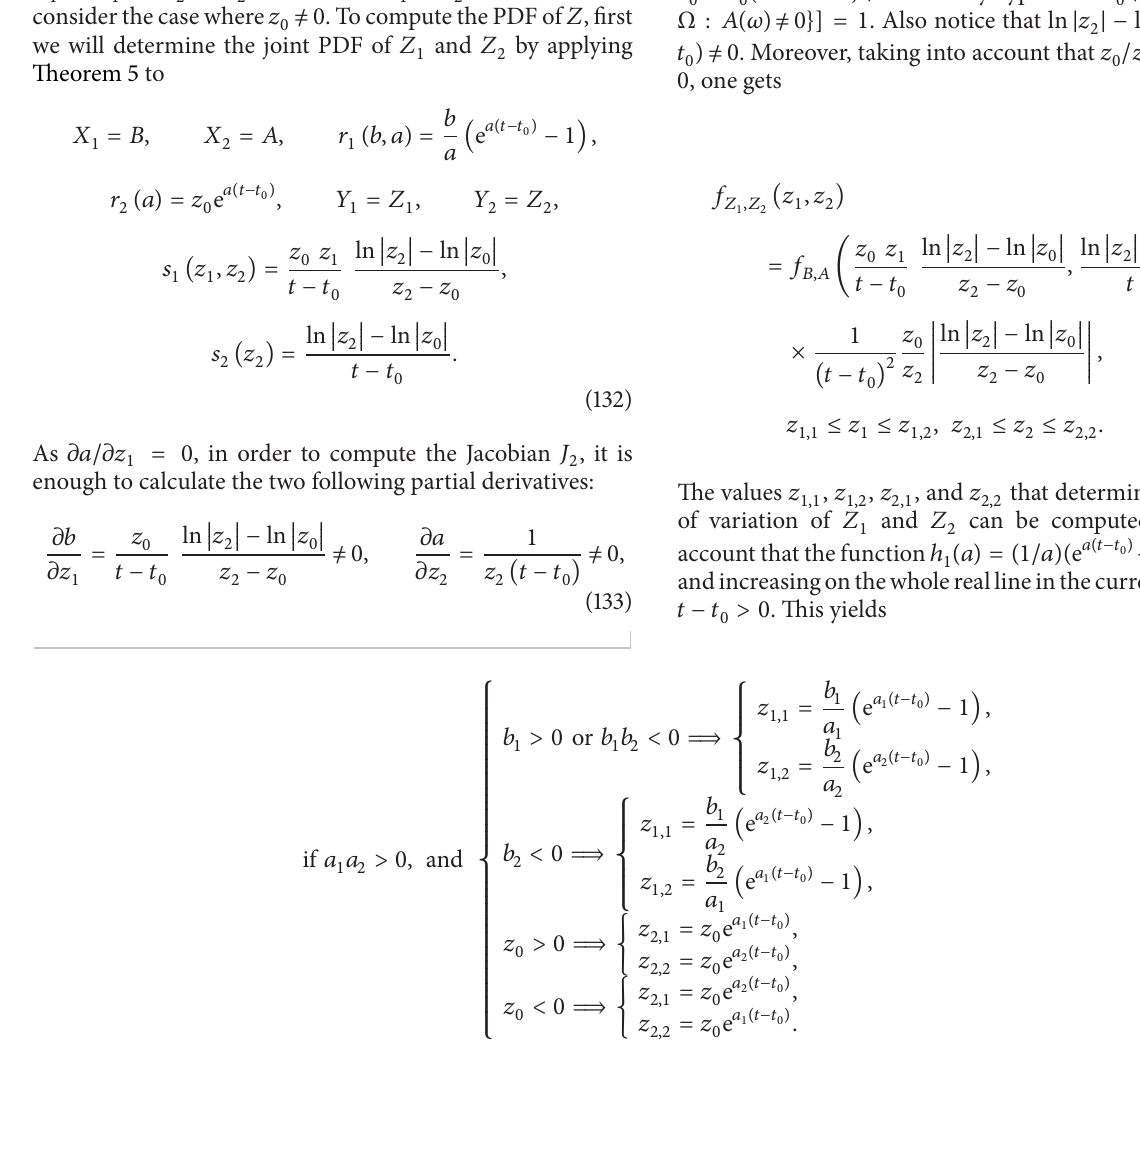
𝜇 = 1 , 𝜇 = 0 , 𝜎 = 0.1 , 𝜎 = 0.1 , 𝜌 = 0.5 , 𝑡 = 0 , and 𝑏 = 1 𝑍 0 𝐴 𝑍 0 𝐴 𝑍 0 ,𝐴 0